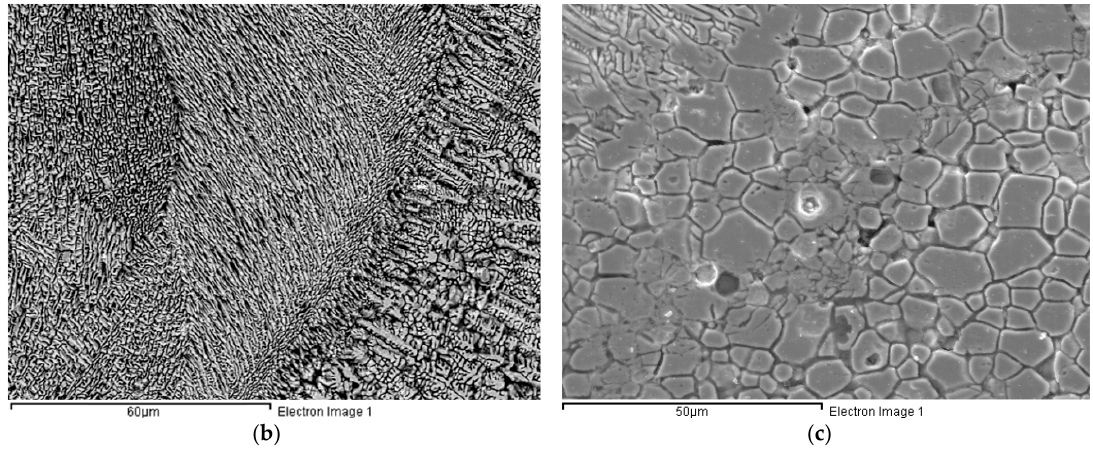
Figure 6. The cross ‐ section of laser spot weld ( a ), and the microstructures of nugget ( b ) and HAZ ( c ) in a laser spot weld.